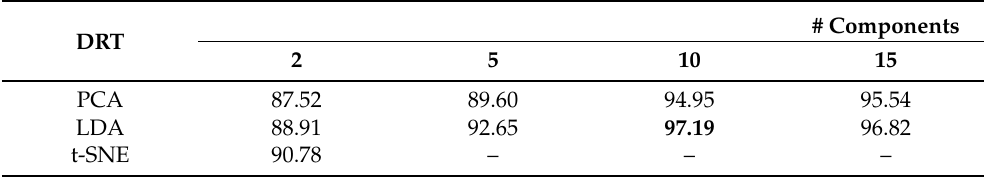
Table 10. The results of gesture recognition rate on the test set of the AUTSL dataset when optimizing the dimensionality reduction components for hand configurations.